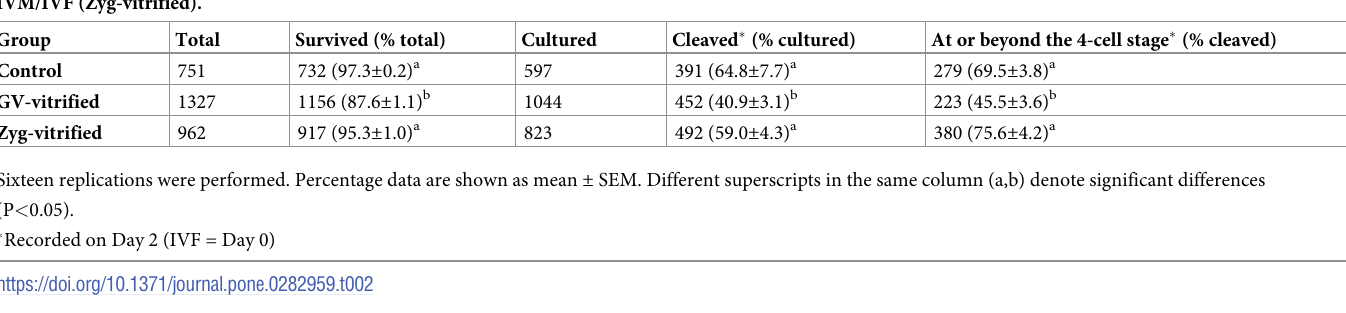
Table 2. Survival and cleavage after IVF of cumulus-enclosed porcine oocytes vitrified either at the GV stage before IVM (GV-vitrified) or at the zygote stage after IVM/IVF (Zyg-vitrified).